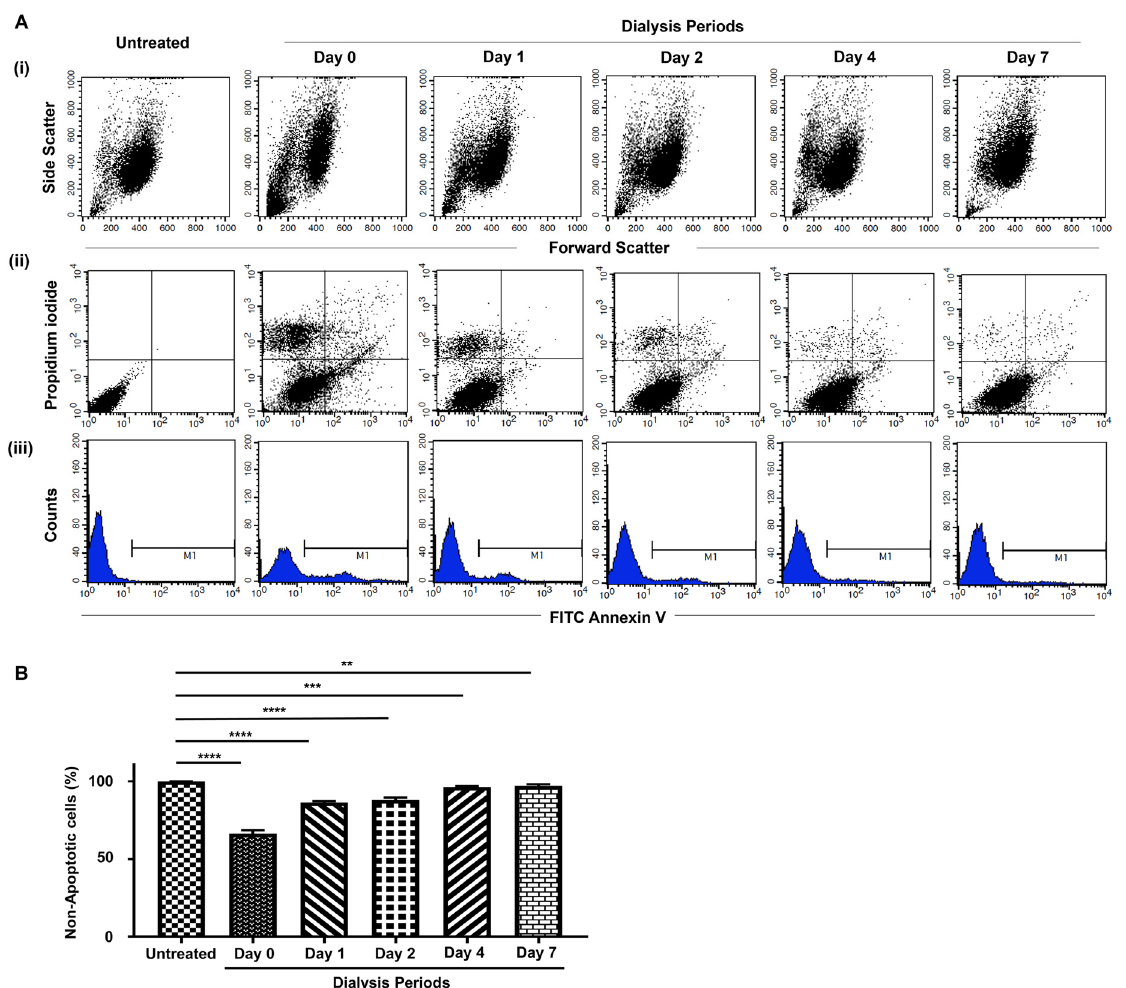
Figure 7. Flow cytometric analysis of necrotic and apoptotic population with Annexin V/propidium iodide staining depending on dialysis periods. ( A ). NIH 3T3 cells treated with 0.1 g/mL of each dialyzed sample on days 0, 1, 2, 4, and 7 for 72 h. (i) The necrotic and apoptotic cell population showed on the light scattering plot; (ii) and (iii) the intensity and percentage of live cells populations (Annexin V-positive) increased gradually following dialysis periods. ( B ). The percentage of necrotic and apoptotic cells were high on dialysis day 0 compared to the untreated sample, and gradually decreased following dialysis periods. **** p < 0.0001, *** p < 0.001, and ** p < 0.05, respectively.